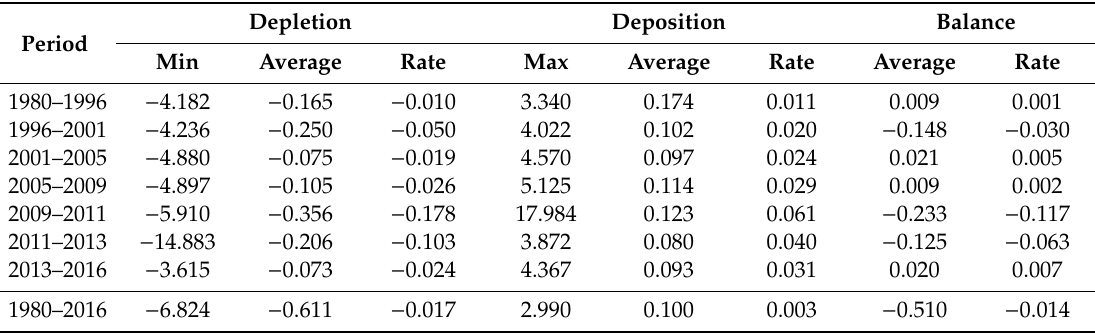
Table 6. Height di ff erences and rates in the gullies of the whole study area 1,2 .